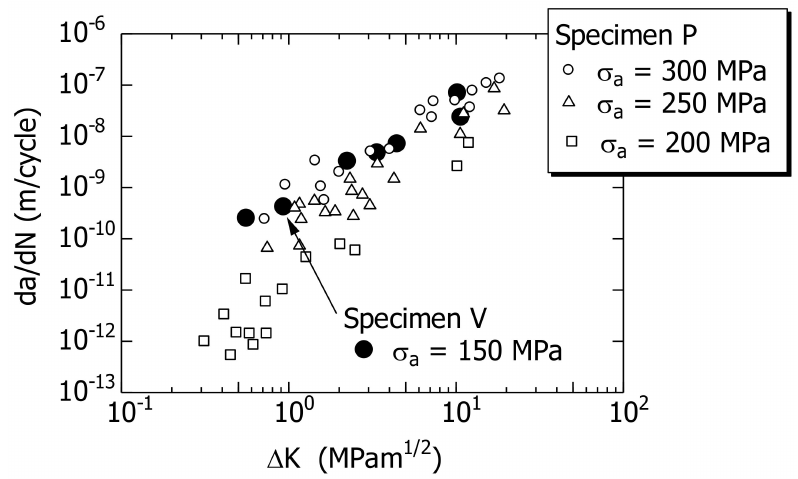
Figure 9. da/dN– ∆ K relationships of short surface cracks in specimens P and V. For specimen P, the da/dN − ∆ K relationships for the three σ a values (200, 250, and 300 MPa) are shown. Focusing on da/dN at a constant ∆ K value, it was observed that da/dN increased with σ a . Linear elastic fracture mechanics (LEFM) cannot be applied to short cracks because of the dependence of σ a in the da/dN − ∆ K relationship for